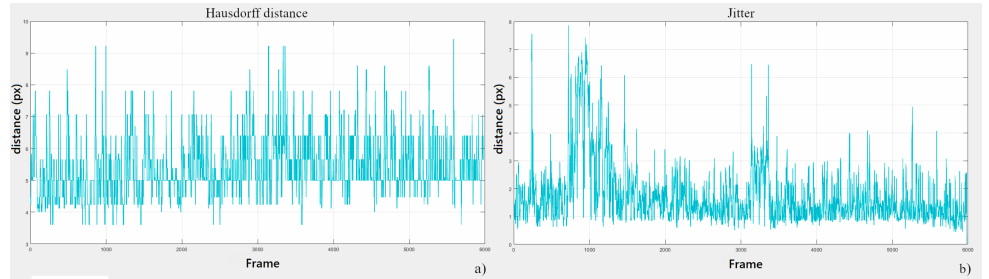
Figure 3. Results of the user test. ( a ) Hausdorff distances between the real trajectories and their corresponding projected trajectories. ( b ) Jitter of the projected